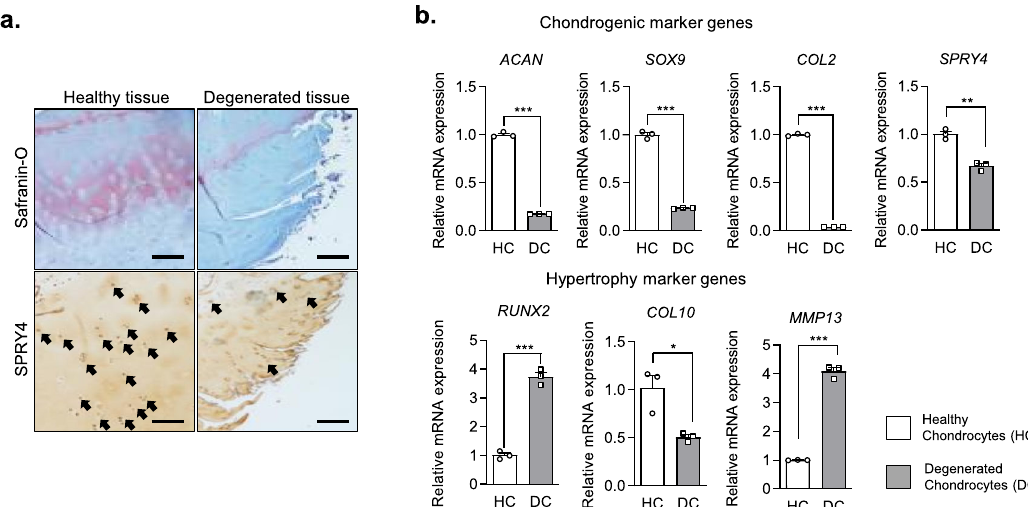
Fig. 1 Expression of SPRY4 in healthy and degenerated human cartilage. a Safranin-O staining (upper panel) and SPRY4 IHC staining (lower panel) in healthy and degenerated human cartilage. Scale bar, 100 μ m. b Chondrogenic marker gene mRNA expression levels (top), hypertrophic marker gene mRNA expression levels (middle), and SPRY4 mRNA expression levels (bottom) in Healthy chondrocytes (HCs) and Degenerated chondrocytes (DCs). The data represent the mean ± SEM ( n = 3; ACAN, SOX9, COL2, and MMP13: unpaired t -test; RUNX2 and COL10: unpaired t -test with Welch ’ s correction; MMP13: Mann Whitney